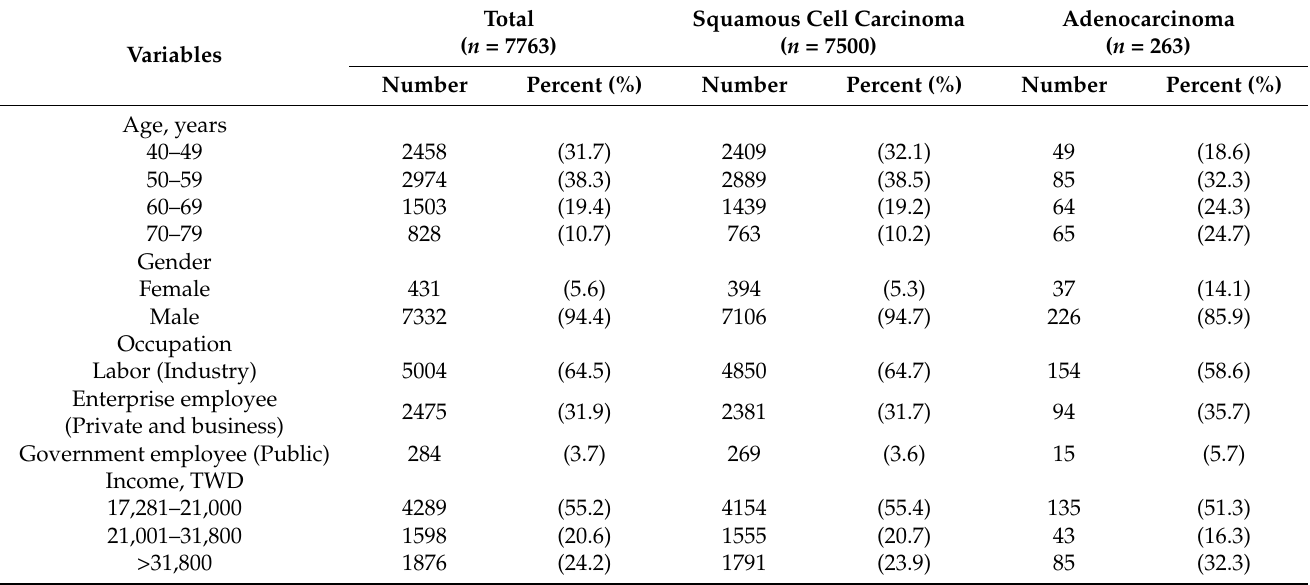
Table 1. Characteristics of patients with esophagus cancer ( n =